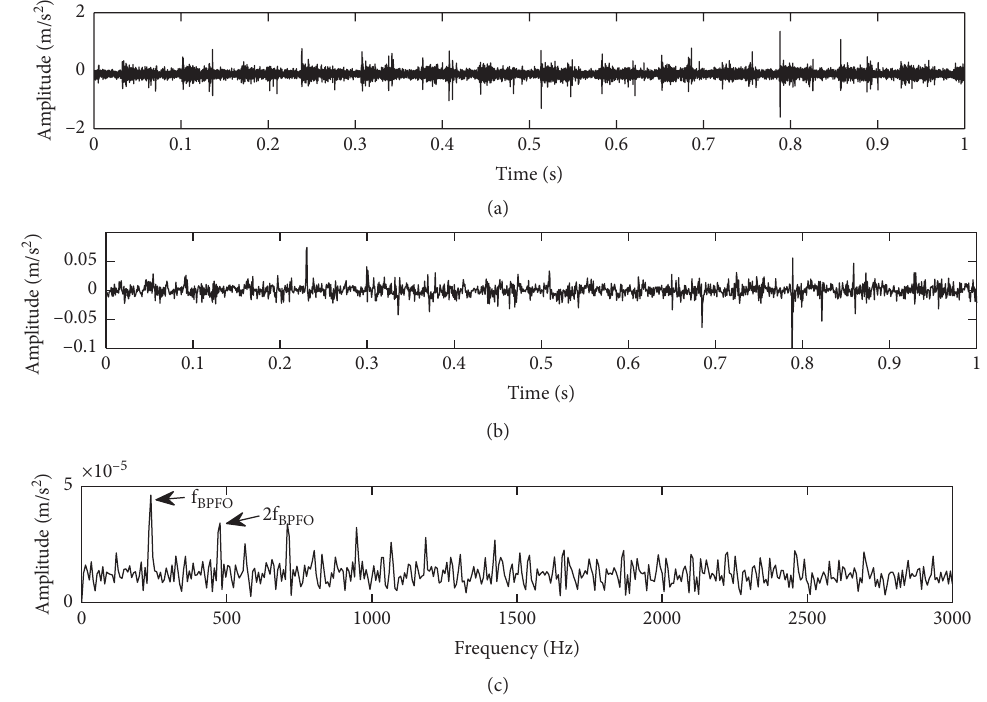
Figure 19: (a) The original signal. (b) The signal filtered by fast computation of protrugram. (c) The square envelope for the filtered